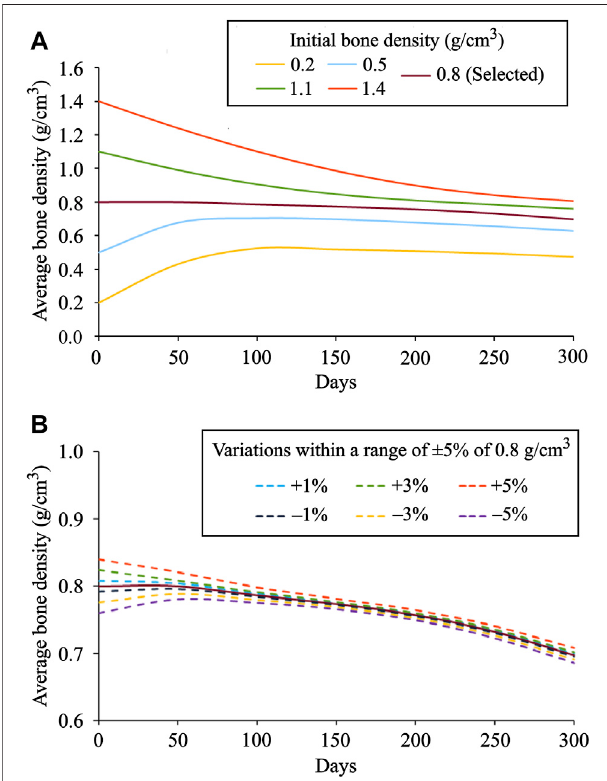
FIGURE 7 | Evolution of average bone density for: (A) distinct values of initial density ranging from 0.2 to 1.4 g/cm 3 and (B) small variations within a rangeof ± 1%, ± 3%,and ± 5%introducedtotheselectedinitialbonedensityof 0.8 g/cm 3